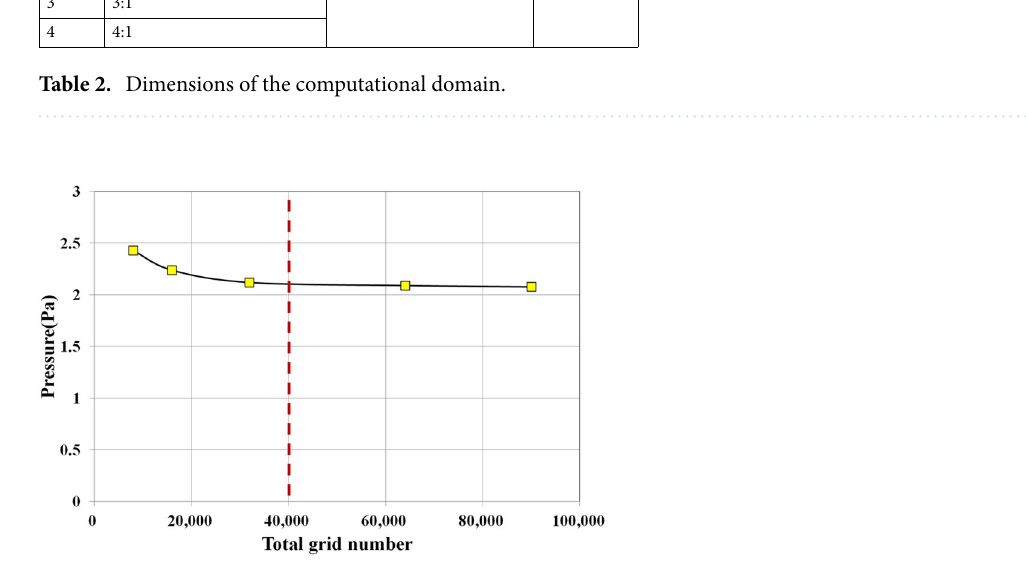
Figure 2. Results of the grid dependence